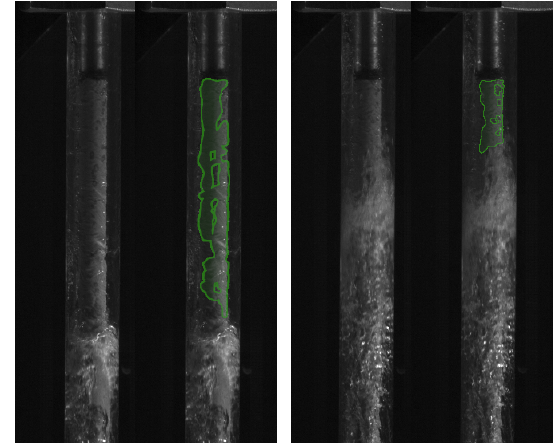
Figure 10. Rewetting of tube